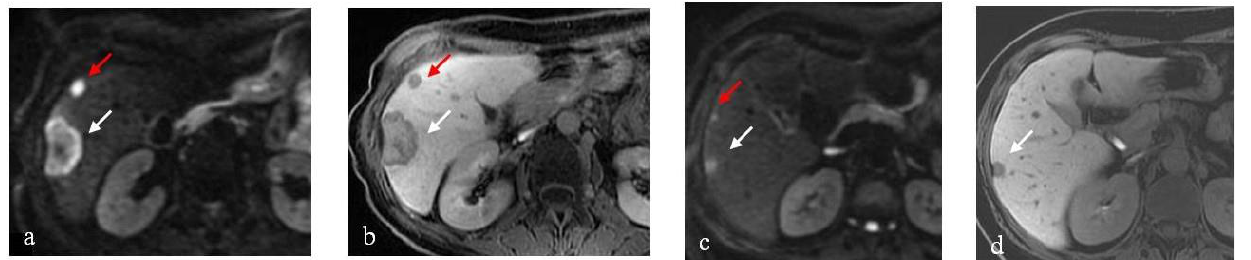
Figure 3. A 53-year-old male who had an RTLM and SRLM after chemotherapy. Two liver metastases in segment V sized 32 mm and 12 mm (white and red arrows, respectively) were identified on diffusion-weighted ( a ) and hepatobiliary phase ( b ) images of baseline MRI. After chemotherapy, the size of the bigger metastasis decreased to 9 mm (white arrow), whereas the smaller one became visible (red arrow) only on diffusion-weighted imaging ( c ) but not on hepatobiliary phase image ( d ) of follow-up MRI.